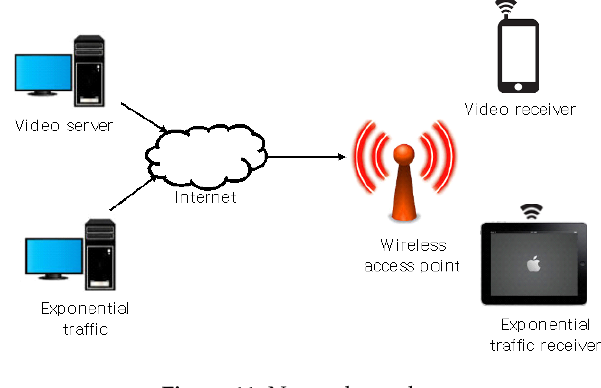
Figure 11. Network topology.